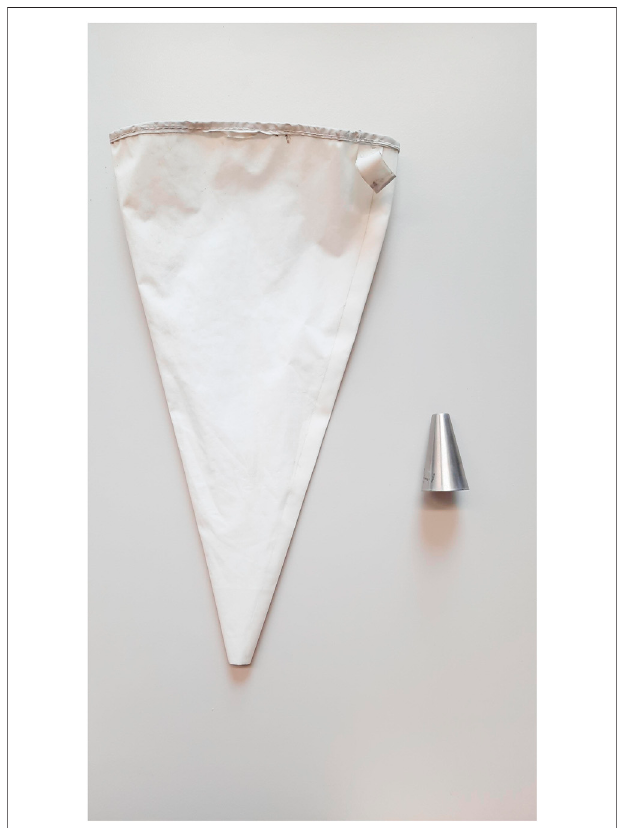
FIGURE 2 | Left , Piping bag used to fi ll in the TBIs; Right , Steel tip attached to the piping bag.